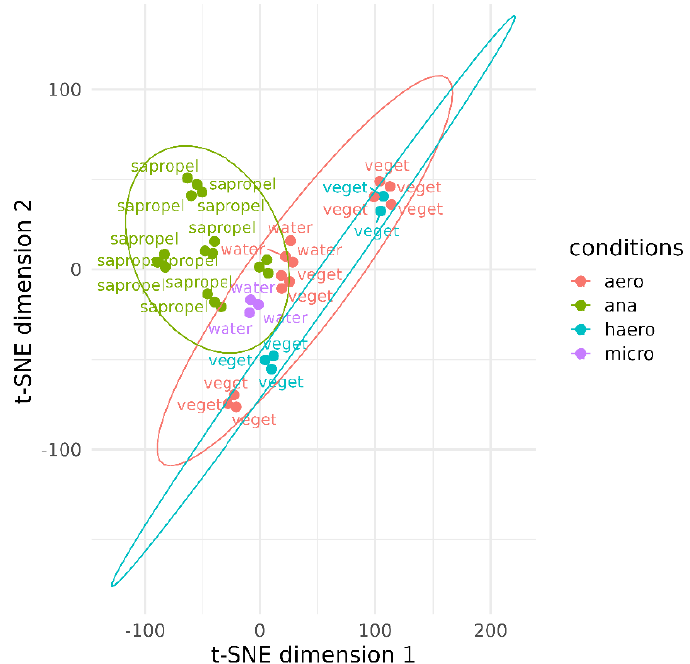
Figure 7. The t – SNE of habitats according to the four levels of dissolved oxygen content (ana, anaerobic; micro, microaerobic; aero, aerobic; haero, hyperaerobic) with superimposed information on the corresponding habitats.